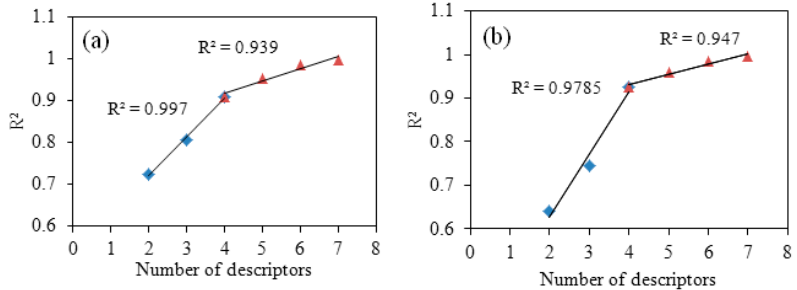
Figure 1. Breaking point rule for determining the number of descriptors (( a ) is breaking point rule for Trametes versicolor ; ( b ) is breaking point rule for Gloeophyllun trabeum ). Table 1. Antifungal activity ratios (AR) and descriptors of cinnamaldehyde analogues for Trametes versicolor .